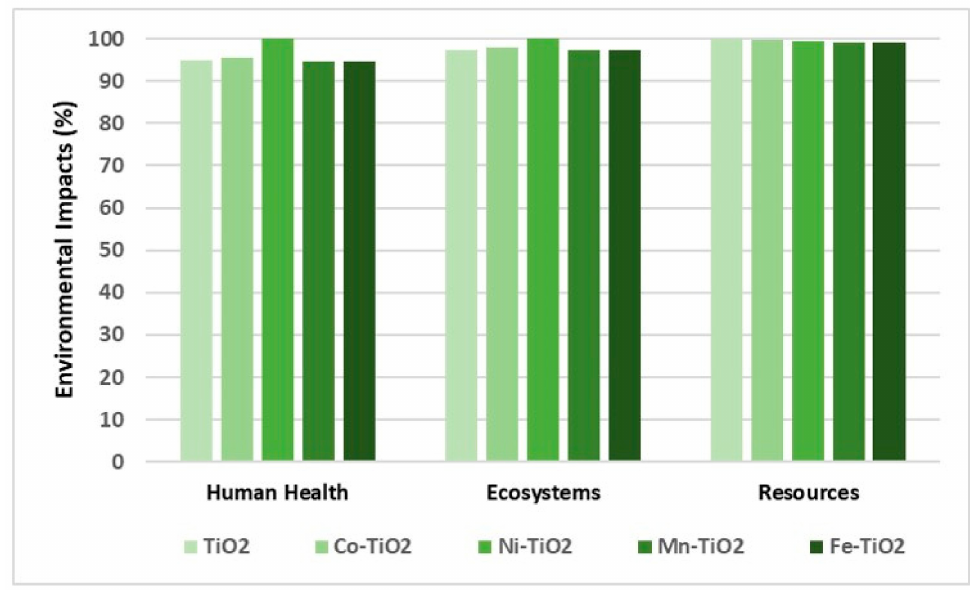
Figure 2. Relative environmental impact of di ff erent TiO 2 photocatalysts, considering a weight-functional unit of 1 kg.